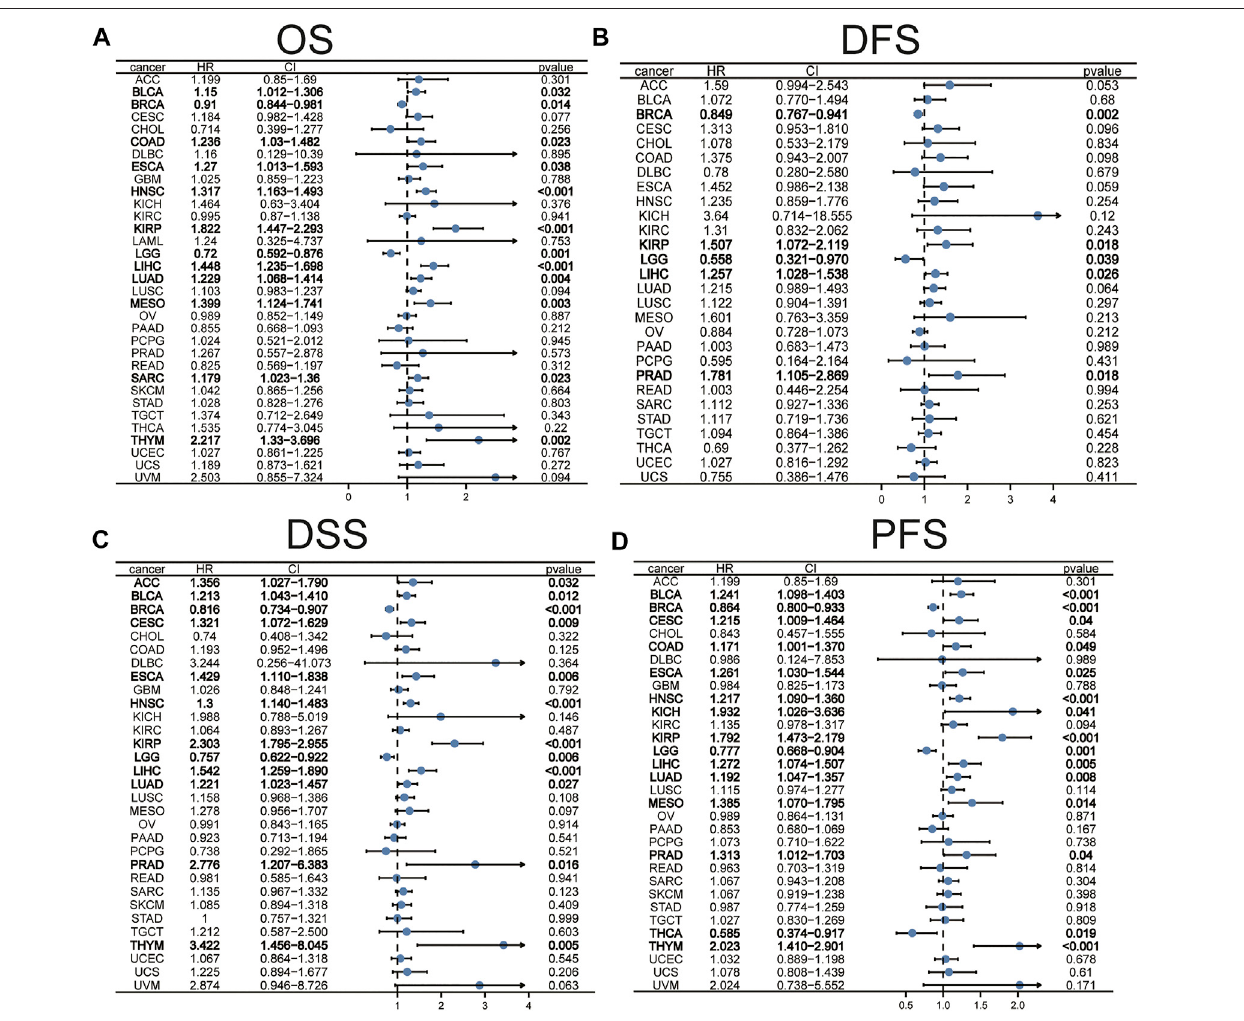
FIGURE5| Theprognosticsigni fi canceofSTC2inpan-cancer.TheassociationsbetweenSTC2expressionlevelsandoverallsurvival (A) ,disease-freesurvival (B) , disease-speci fi c survival (C) , and progress-free survival (D) in various cancer types were illustrated by the forest plots.